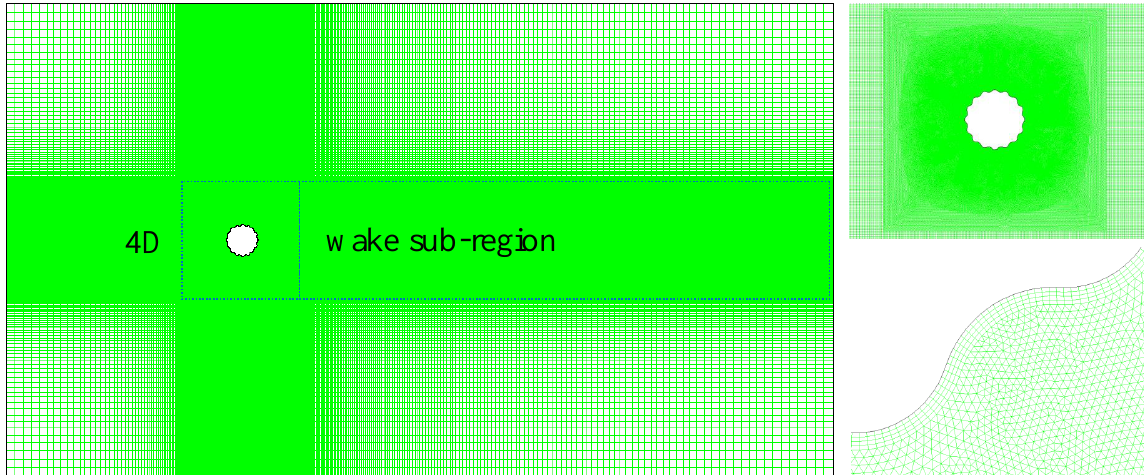
Figure 4. Mesh of the flow field for simulation runs of a single cylinder of a cactus-shaped cross